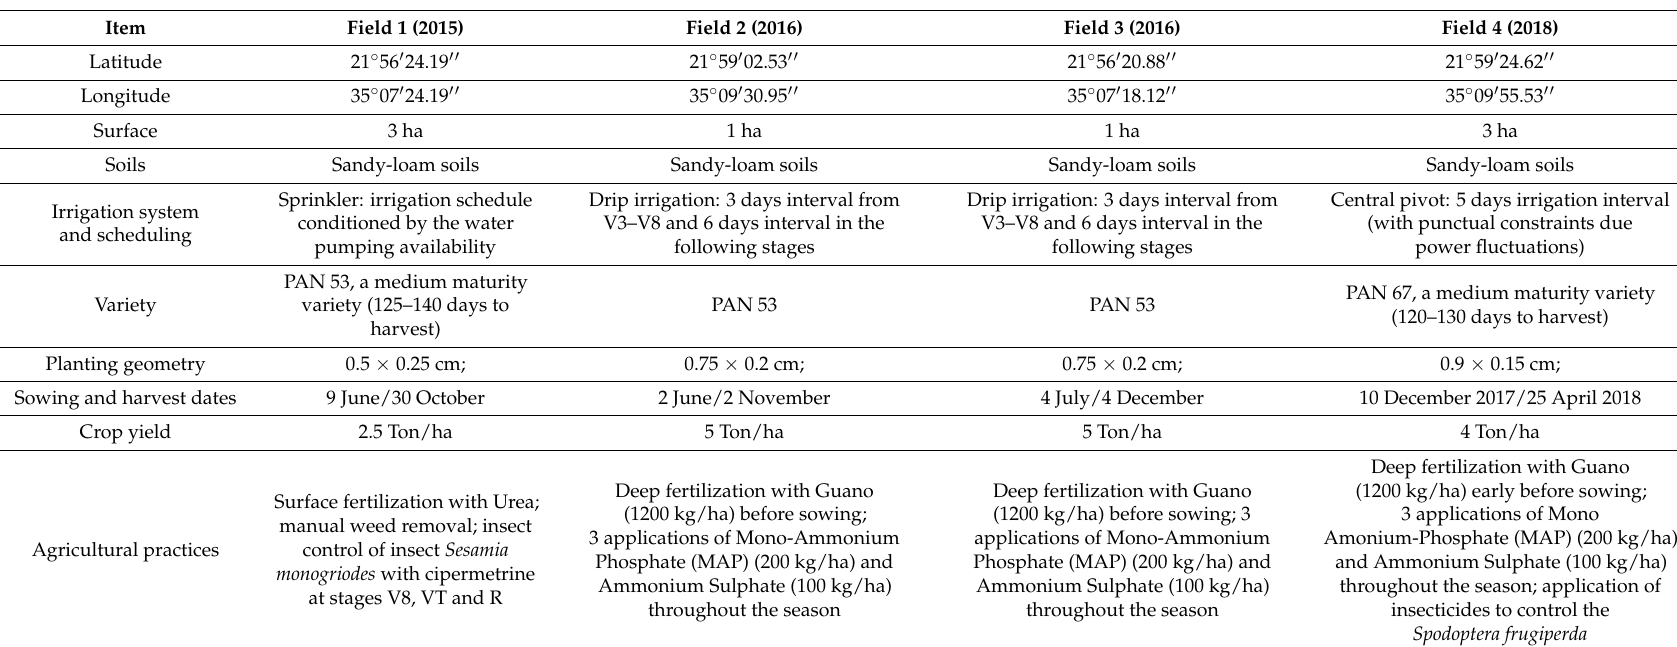
Table 1. Characteristics and main agricultural practices of the sampled